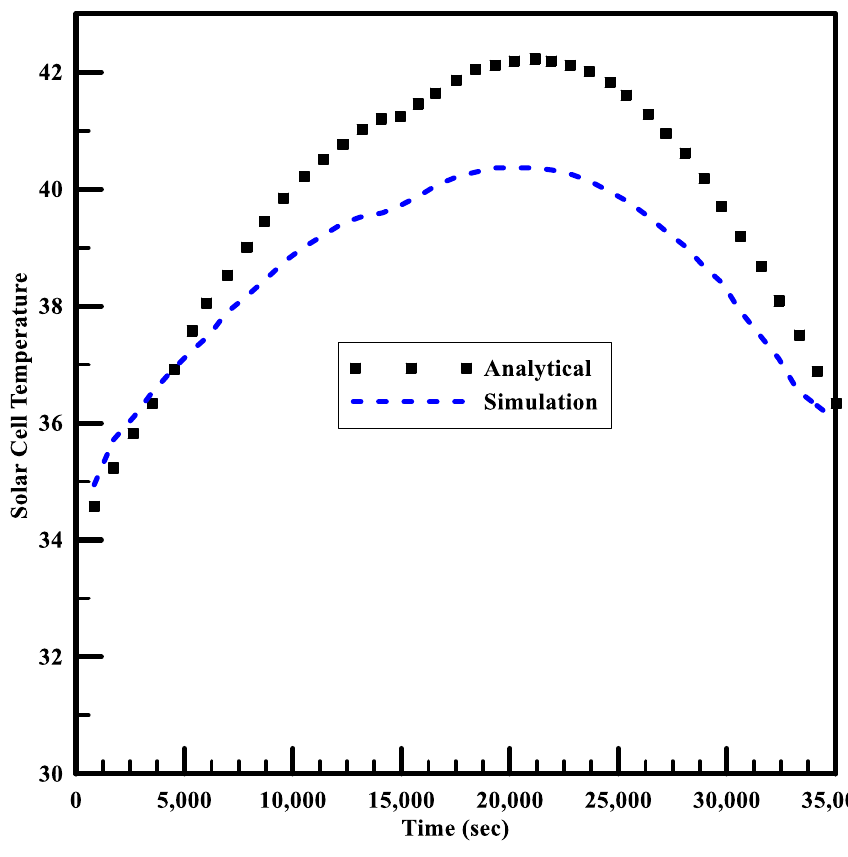
Figure 15. Analytical vs. simulated trends with multi-pass cooling.